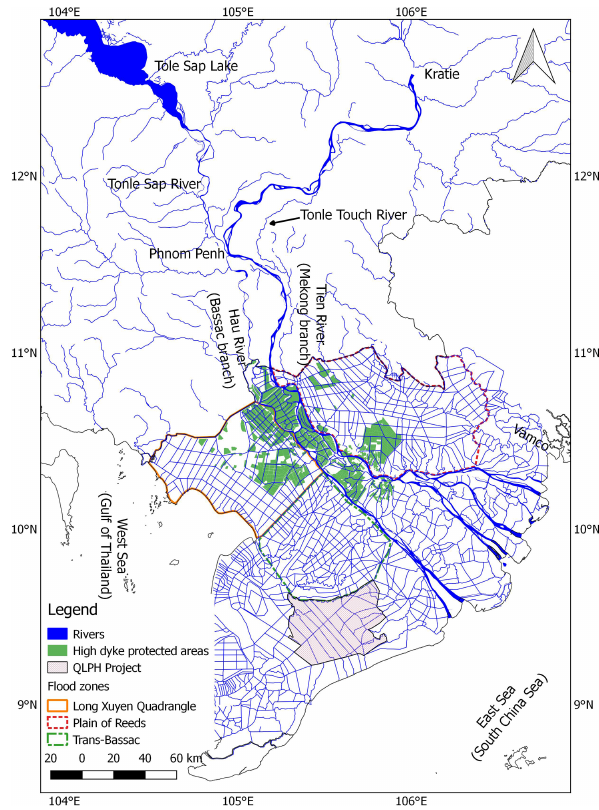
Figure 1. Location of the Mekong Delta. Adapted from the De- partment of Agriculture and Rural Development of An Giang and Dong Thap